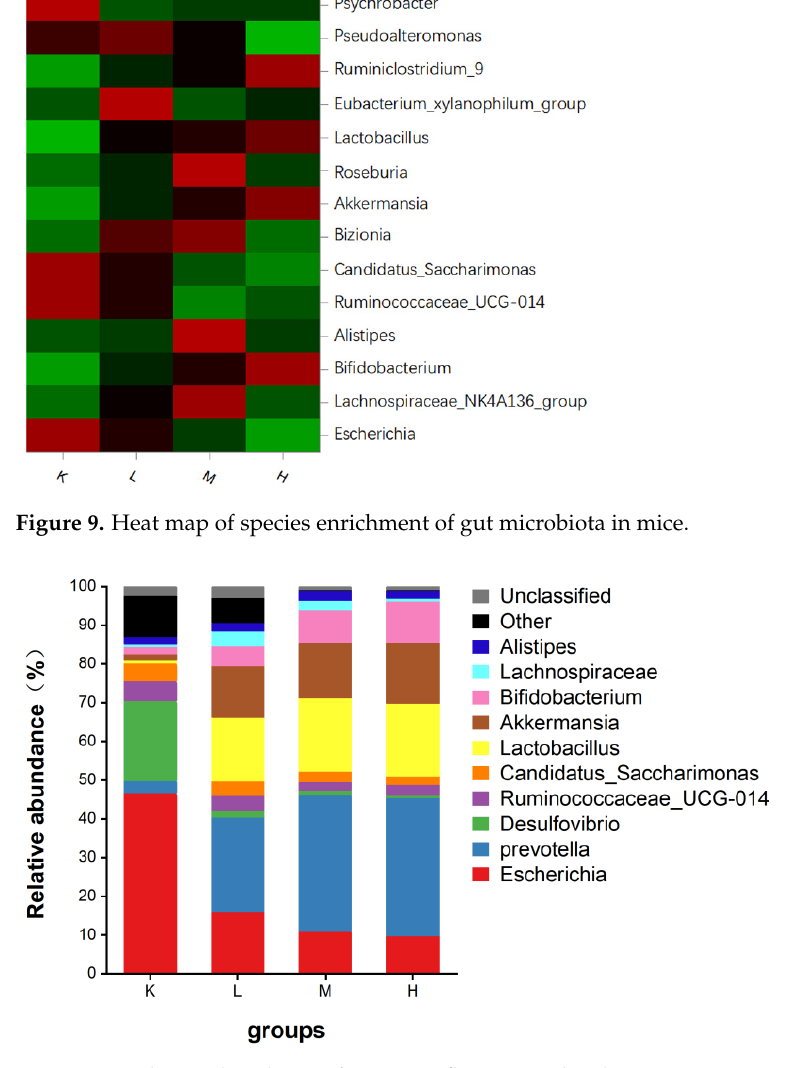
Figure 10. Relative abundance of gut microflora genus levels in mice.